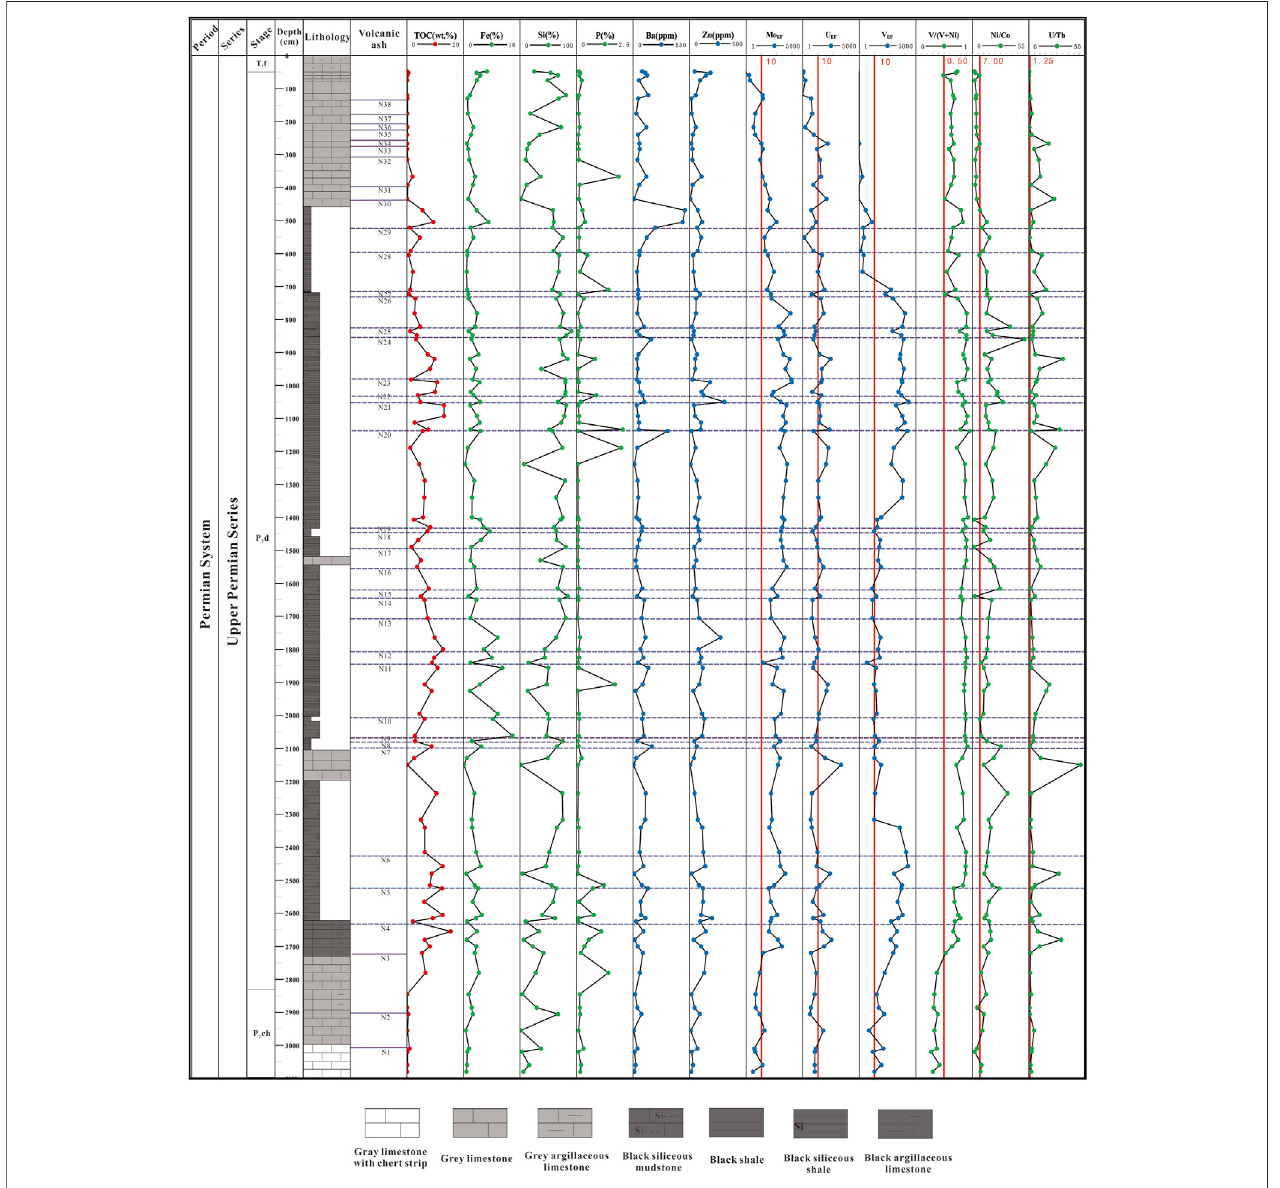
FIGURE 12 | Geochemical element indexes of Longfeng quarry pro fi